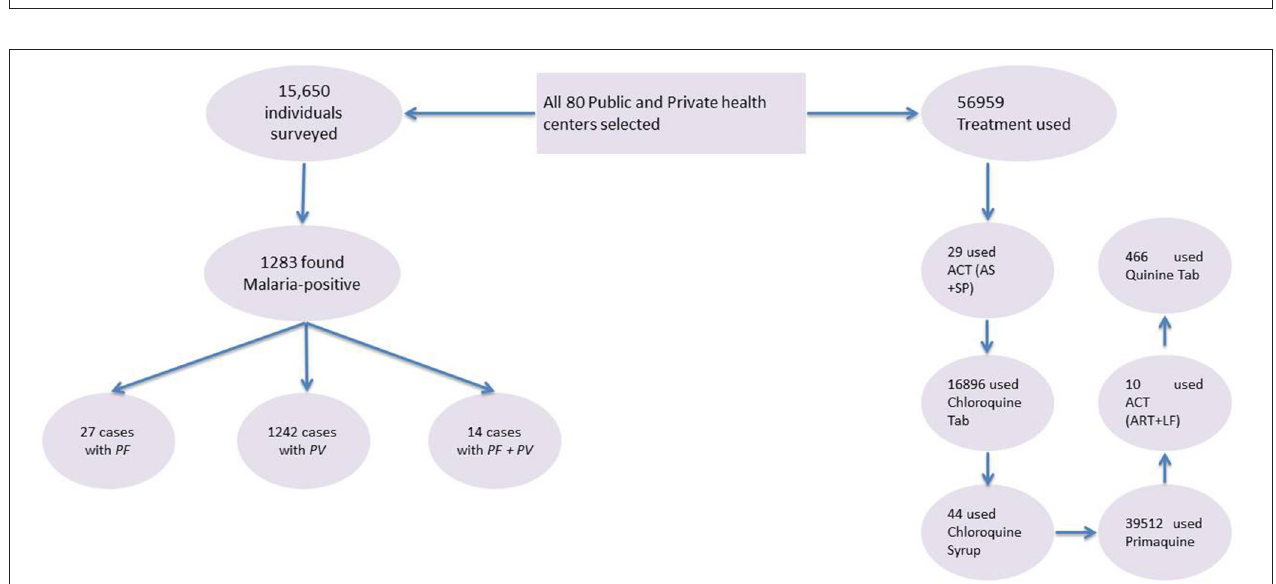
Frontiers in Medicine |